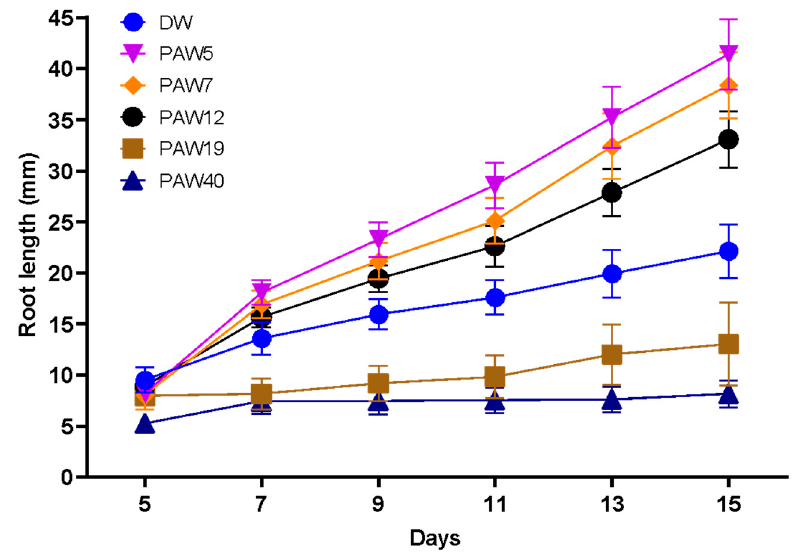
Figure 2. Plasma-activated water promotes root elongation during early root development in Arabidopsis thaliana L.